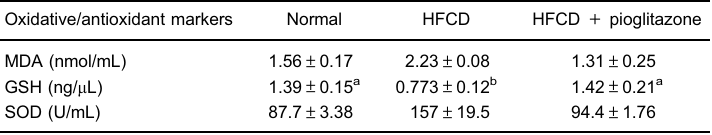
Data are reported as means ± SE. Different superscript letters indicate a signi fi cant difference at P p 0.05 (ANOVA).